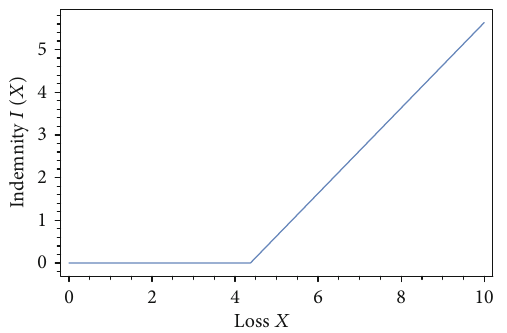
Figure 1: Optimal indemnity for the insured under the illustration model setting.